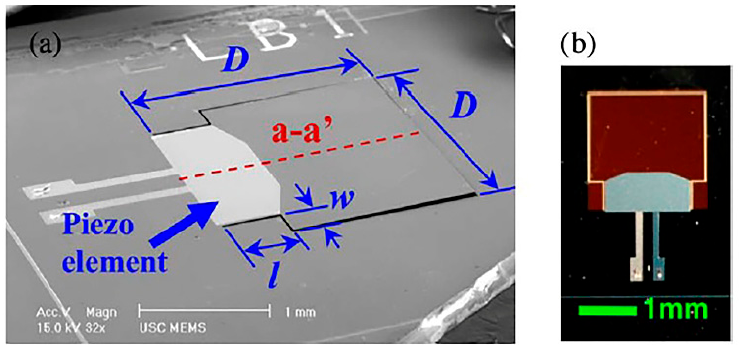
Figure 28. ( a ) Scanning electron microscopy image and ( b ) top view optical image of a single paddle-shaped cantilever microphone. © 2013 IEEE. Reprinted, with permission, from [91].